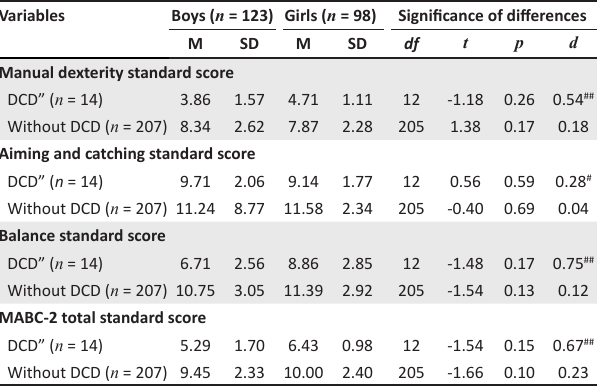
TABLE 3: Differences between boys and girls with and without developmental coordination disorder in the different MABC-2 subdivisions. Variables